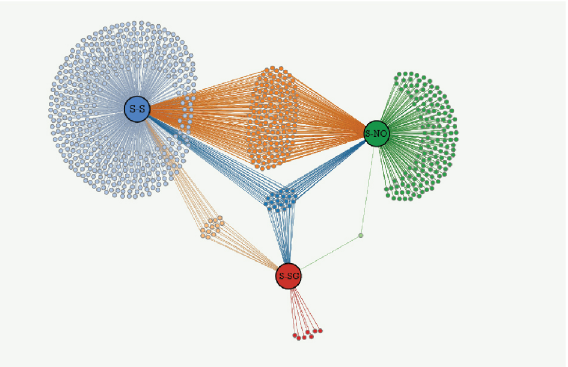
Figure 11: Redox PTMs network in C. reinhardtii . Proteins undergoing glutathionylation (S-SG), nitrosylation (S-NO) and/or reduction by thioredoxin (S-S) are grouped by the nature of their redox modification either in single-modification clusters or intersecting multiple modification